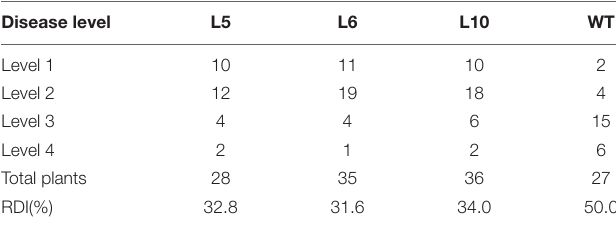
TABLE 2 | Disease grade statistics of GbEDS1 transgenic and wild type